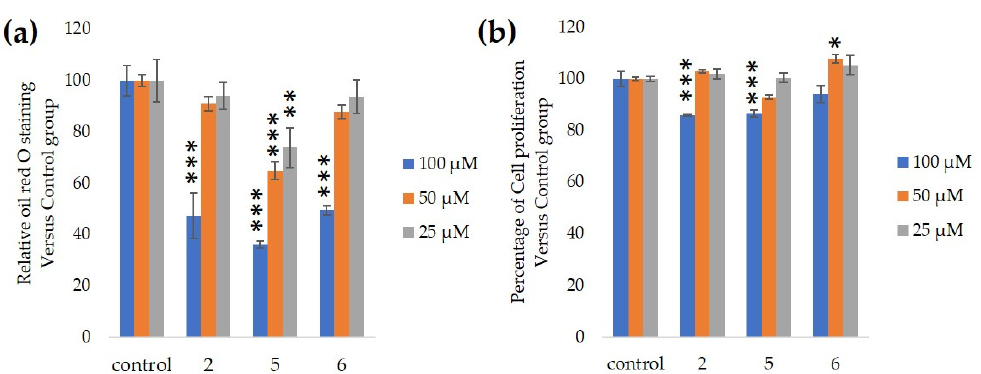
Figure 4. E ff ects of compounds 2 (GiA-7), 5 (stephanoside C) and 6 (stephanoside B) on 3T3-L1 cell di ff erentiation. ( a ) Inhibition of adipogenesis. ( b ) Cell proliferation. Values are shown as means ± SD ( n = 4). * p < 0.05, ** p < 0.01 and *** p < 0.001 vs. control (ANOVA and post hoc Dunnett tests).